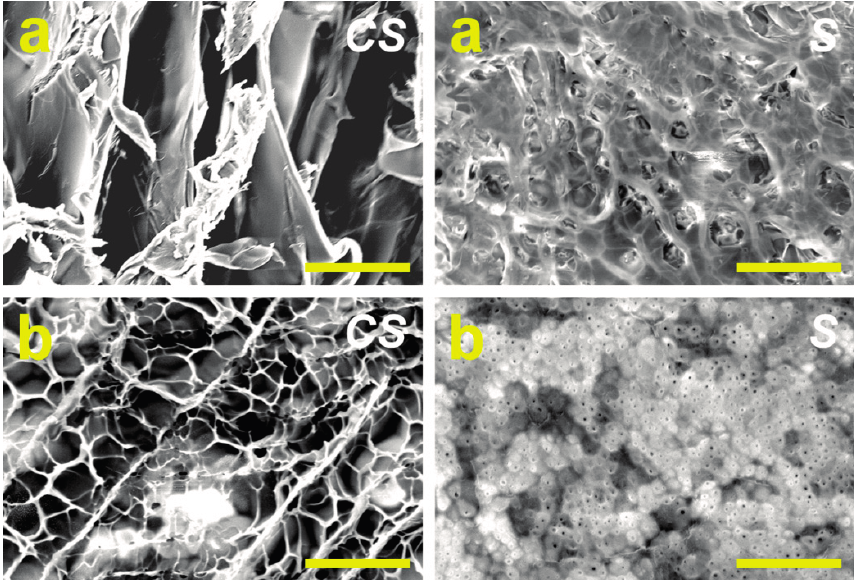
Figure 1. Scanning electron microscopic images of various hyaluronic acid (HA) carriers. ( a ) High pre-freezing temperature (HFT) and ( b ) low pre-freezing temperature (LFT) groups. CS: cross-section; S: surface. Scale bars: 200 μ m.